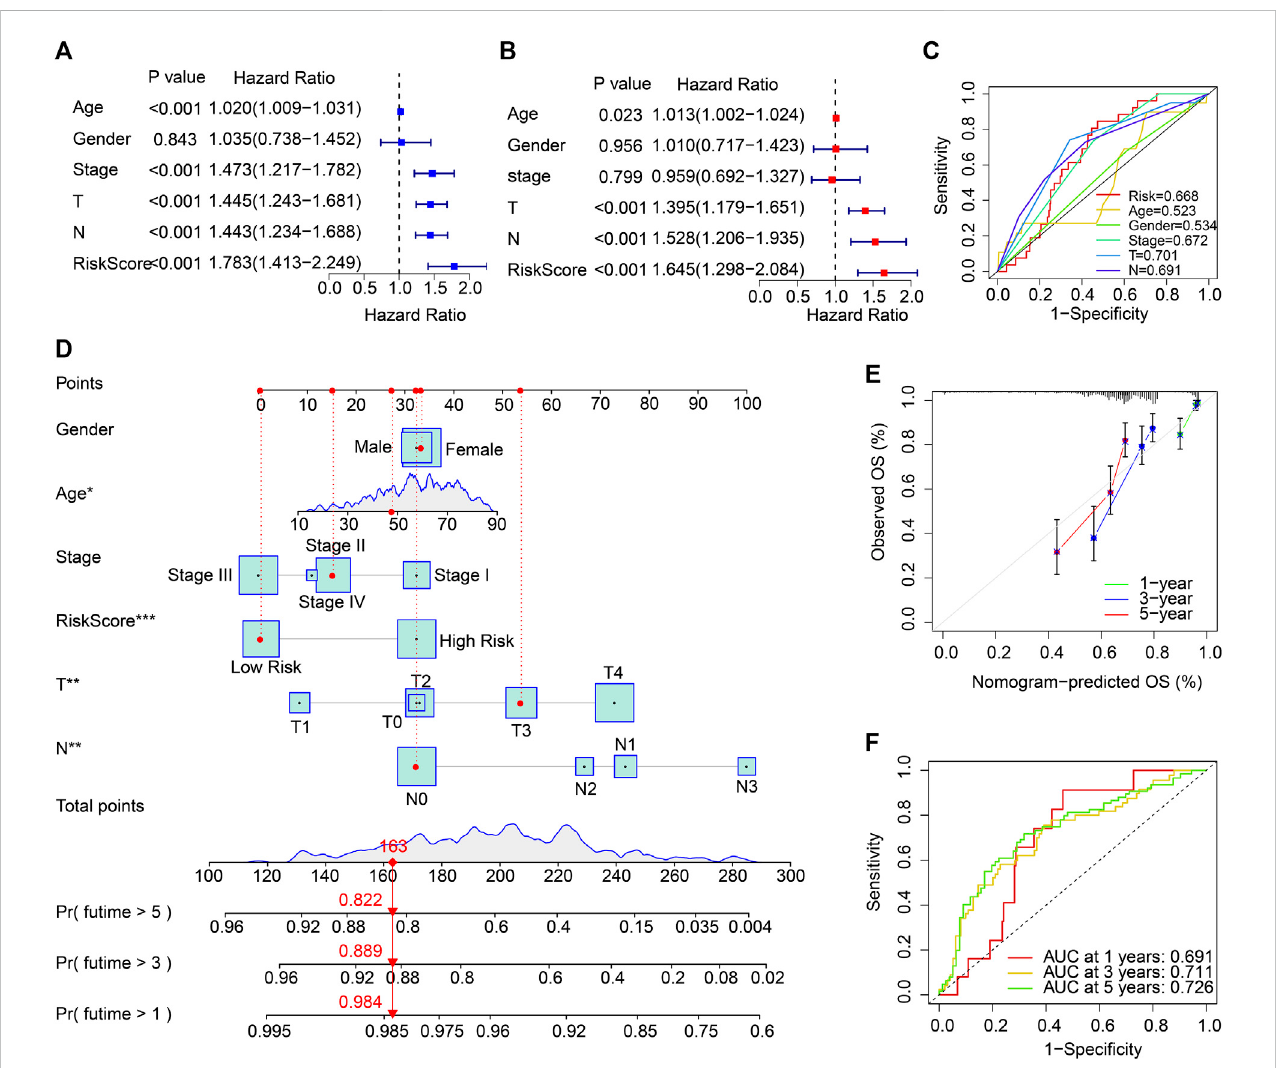
FIGURE 4 Independent ARG prognostic signature-based prognosis analysis and clinicopathological characteristics in the TCGA cohort. (A) The association results suggested by univariate Cox regression analyses. (B) Multivariate Cox regression analyses indicate that the ARG prognostic signature is an independent prognosispredictorforCM. (C) ROCcurvedisplaystheAUCofARGprognosticsignaturesandotherclinicopathologicalcharacteristics. (D) Nomogramofthe ARGprognostic signatures andclinicopathologicalcharacteristicsto predictthesurvivaltime ofpatients withCM. (E) Calibrationcurveanalysisofthe1-, 3-, and 5-year OS rates predicted by nomogram and actual OS rates. (F) The AUC of the time-dependent ROC